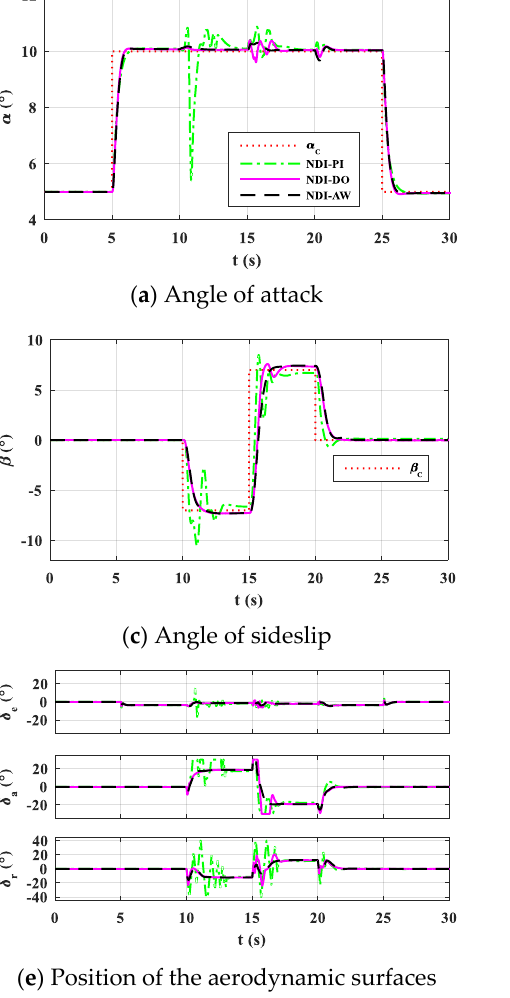
Figure 9. Response of the tailless aircraft model controlled using NDI-PI, NDI-DO, and NDI-AW with the actuator saturation.